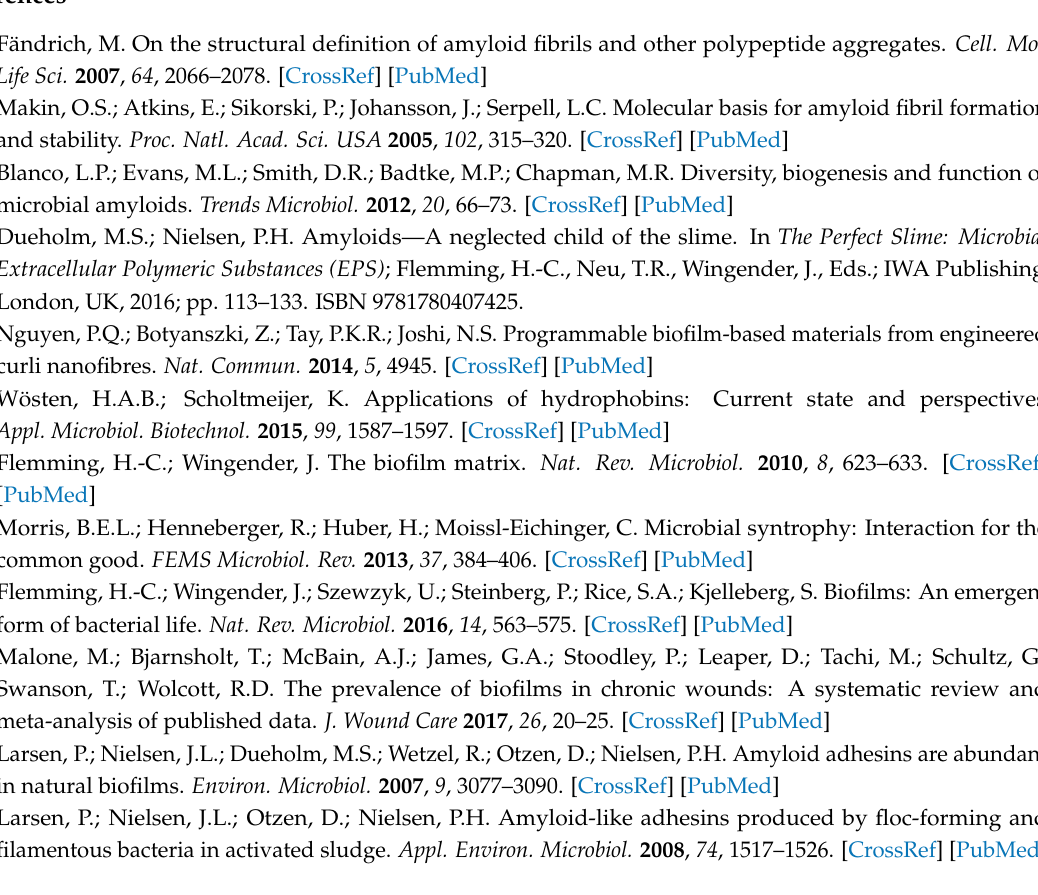
Figure S1: Abundance profiles for all proteins in the E. coli SM2258 sample, Figure S2: Abundance profiles for all proteins in the Pseudomonas sp. UK4 sample, Table S1: Amyloid candidates identified in the E. coli SM2258 sample, Table S2: Amyloid candidates identified in the Pseudomonas sp. UK4 sample, Script S1: R-markdown script used for automated identification of amyloid protein